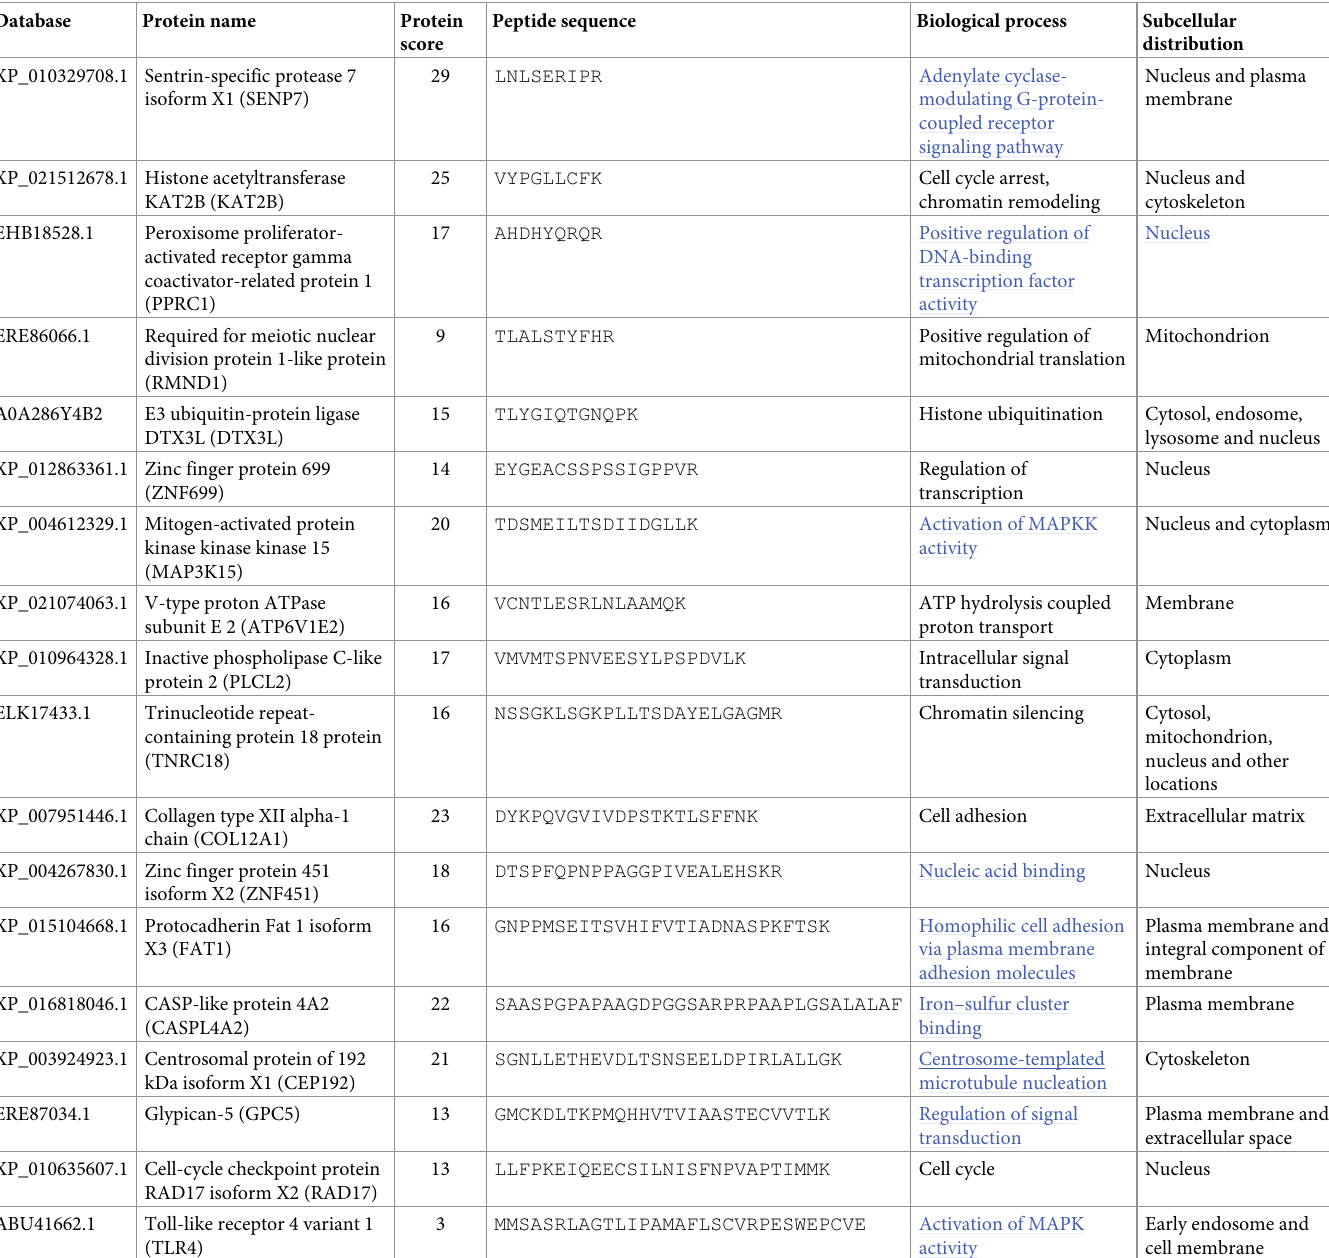
Table 1. Nominated proteins based on biological process involvement and protein score, using MALDI-TOF MS and LC-MS/MS data.